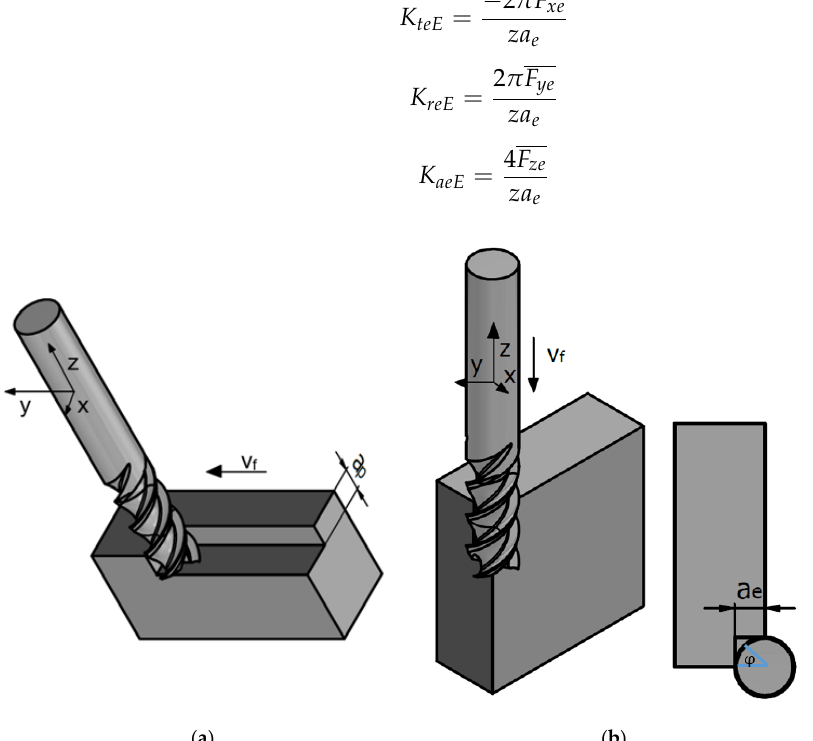
Figure 7. Scheme of determining cutting forces during turn-milling.